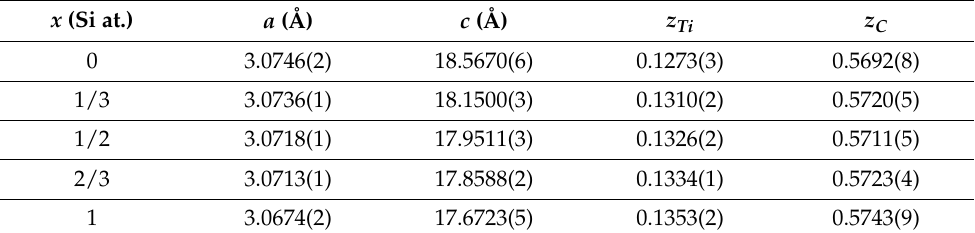
Table 2. Structural data of the dominant Ti 3 (Al 1 − x Si x )C 2 hexagonal phase (space group P 6 3 /mmc) obtained from the Rietveld analysis of X-ray diffraction patterns of Ti 3 (Al 1 − x Si x )C 2 bulk samples with x = 0, 0.33, 0.5, 0.67 and 1: a , c —hexagonal unit cell parameters, z Ti , z C —positional parameters for Ti (4f) and C (4f) sites, respectively.